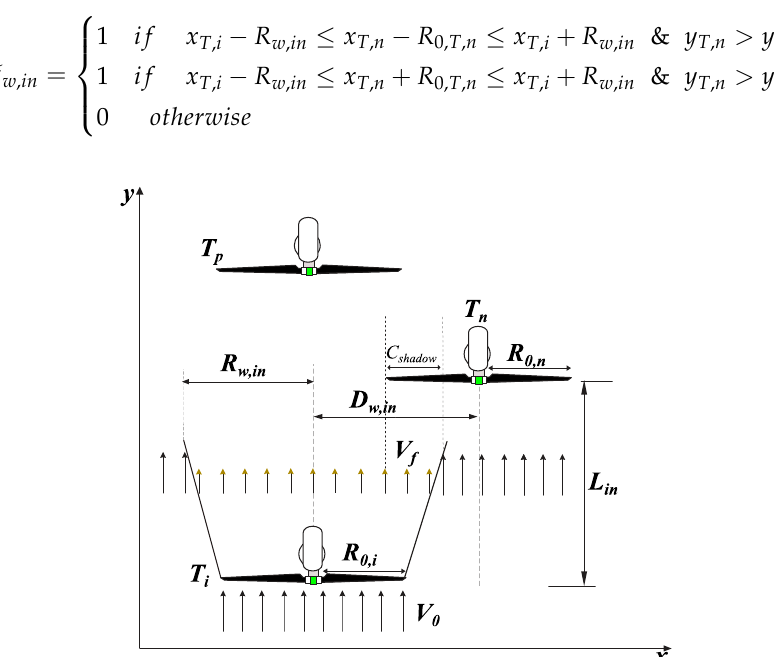
Figure 3. Illustration of the wake effect of T